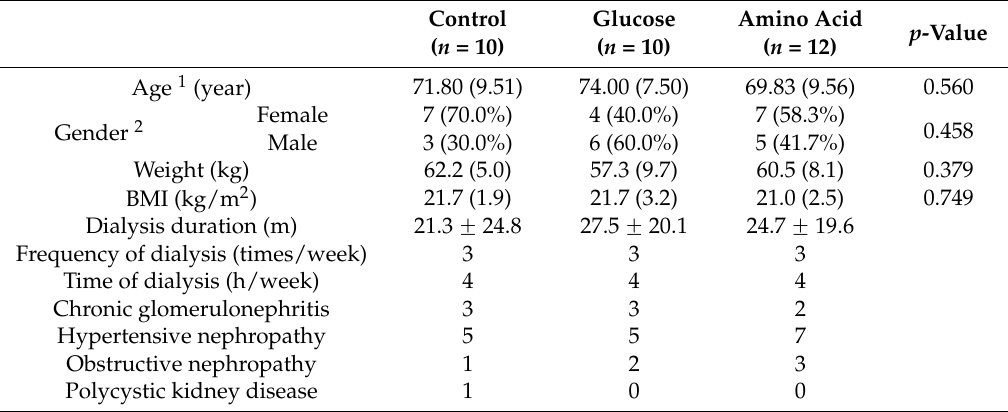
Table 1. Baseline characteristics of the three treatment groups.